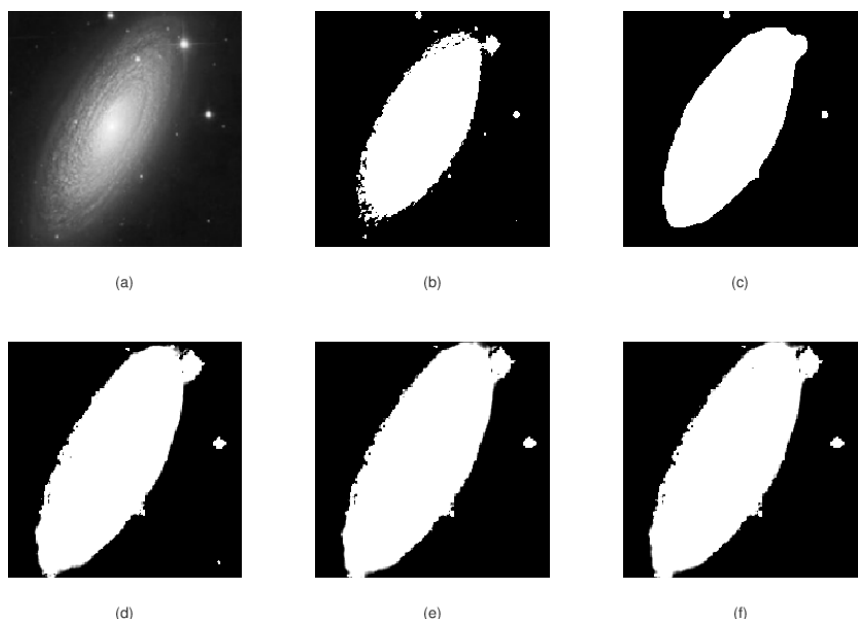
Figure 3. ( a ) Input image to be segmented; ( b ) K-means segmentation results; ( c ) Chan–Vese segmen- tation results; and ( d–f ) Our model segmentation results after 1–3 iterations. respectively.